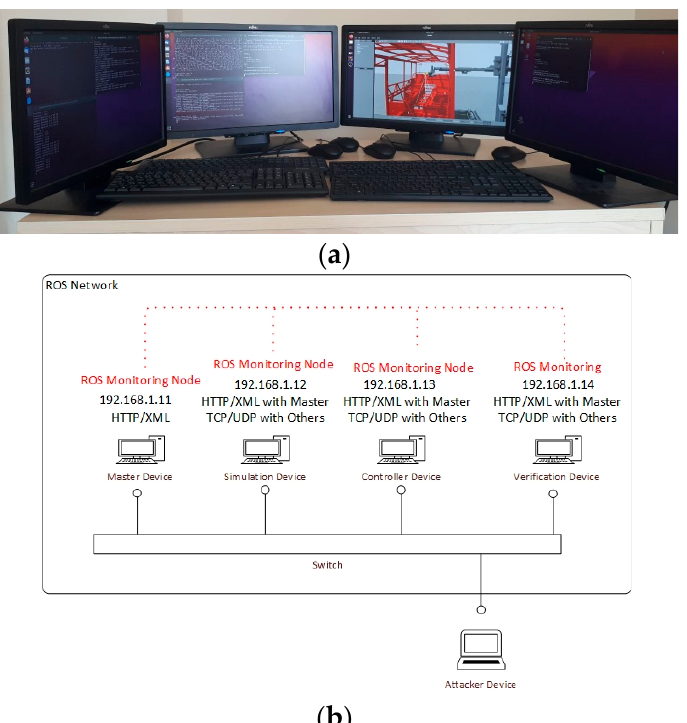
Figure 4. The experiment environment: ( a ) laboratory environment; ( b ) test-bed devices explana- tions.